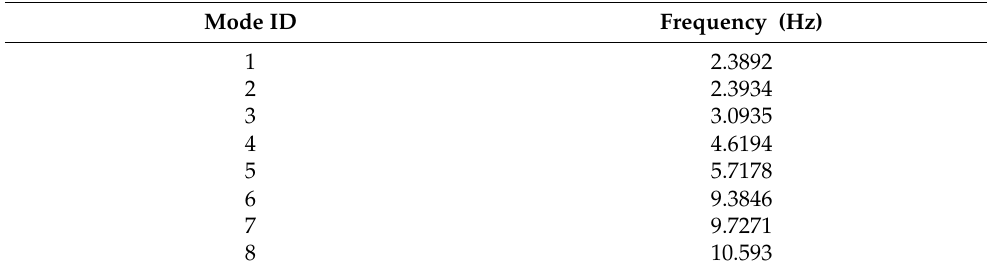
Table 2. Numerical natural frequencies of the validation